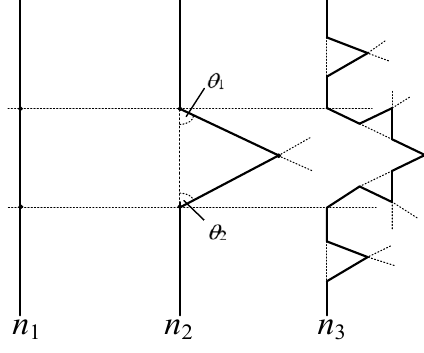
Figure 2. Iterative process of Koch curve.